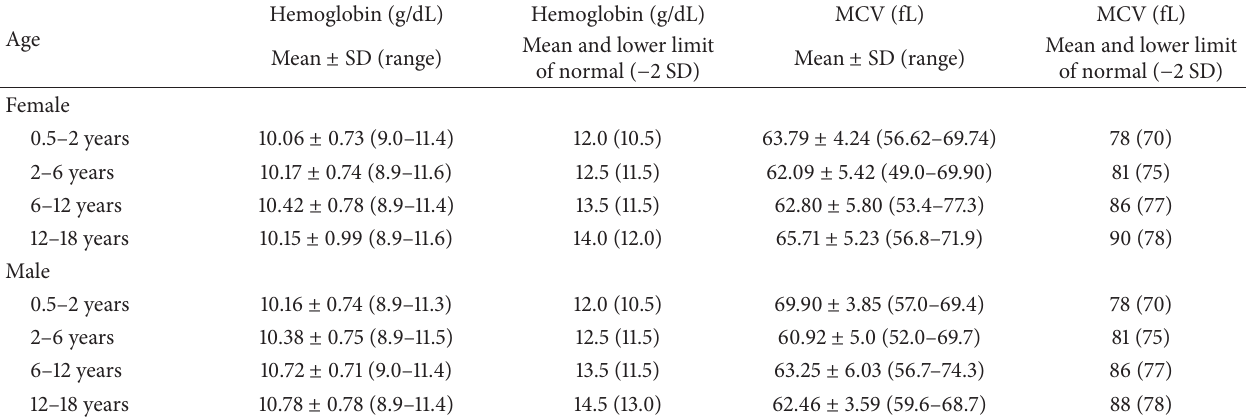
Table 5: Red cell values at various ages of study groups and mean and lower limit of normal ( − 2 SD).